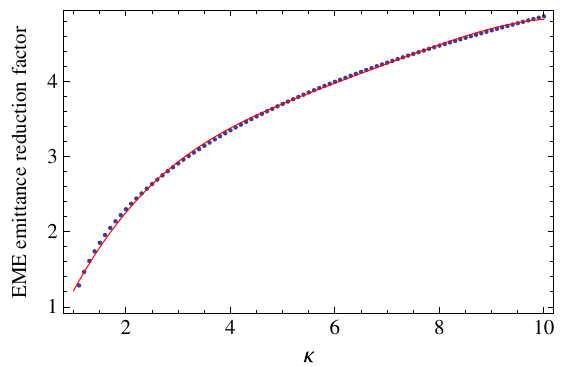
FIG. 13. The initial beta over dipole length for the minimum EME emittance. The red curve is given by the approximate ¼ 0 : 593 =(cid:12) þ 1 : 22 =(cid:12) 2 . =L expression (cid:8) 0 dipole